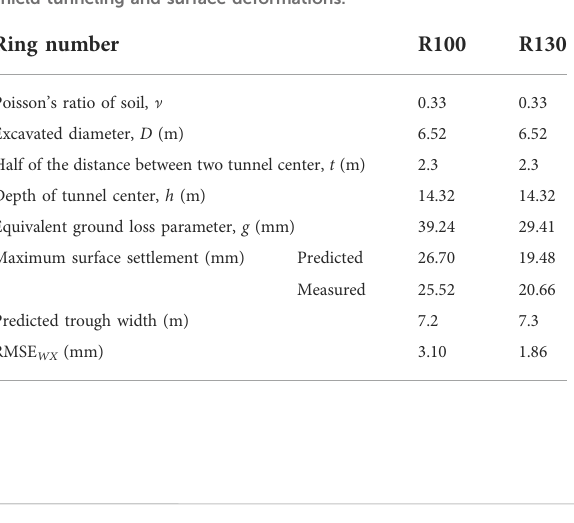
TABLE 5 Calculation parameters of soil deformation induced by DOT shield tunneling and surface deformations.